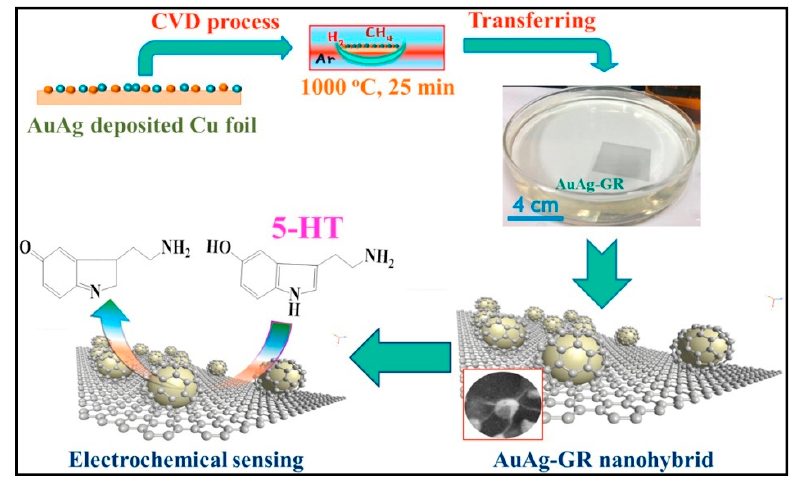
Figure 3. Scheme of fabrication and application of the AuAg-GR nanohybrid material for 5-HT detection. Reprinted from [92] with permission of Elsevier.